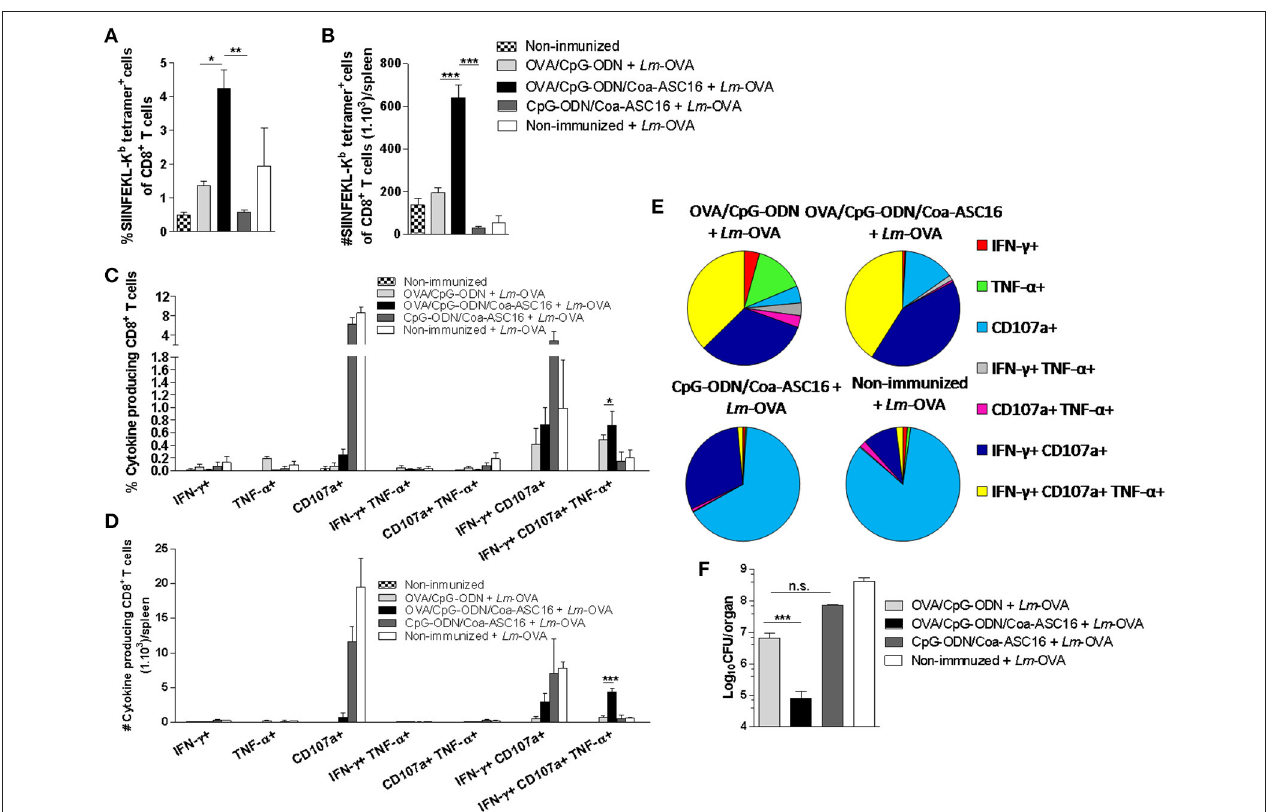
FIGURE 8 | CD8 + T-cell response induced by the nanostructured formulation protects against Lm -OVA infection. C57BL/6 mice were immunized on day 0 with OVA/CpG-ODN, OVA/CpG-ODN/Coa-ASC16 or CpG-ODN/Coa-ASC16. Seven days later, immunized and non-immunized mice were intravenously infected with 1 × 10 5 CFU of Lm- OVA. Two days after infection, mice were euthanized for liver and spleen extraction. (A) Percentage of SIINFEKL-K b tetramer + CD8 + T-cells in spleen. (B) Total number of SIINFEKL-K b tetramer + CD8 + T-cells/spleen. (C–E) CD8 + T-cell cytokine production from splenocytes after in vitro stimulation with SIINFEKL peptide. Multiparameter flow cytometry was used to determine (C) percentage and (D) total number of CD8 + T-cells expressing each of the seven possible combinations of IFN- γ , TNF- α , and CD107a, (E) the fraction of the total CD8 + T-cell response comprising cells expressing each of the seven combinations of IFN- γ , TNF- α and CD107a. For gating strategy and representative flow cytometry data, see Supplementary Figure 4 . (F) Bacterial load in liver. The data show the mean ± SEM of individual values (3–4 mice/treatment group in each experiment) and are representative of two independent experiments performed. n.s., not significant, * p < 0.05, ** p < 0.01, *** p <